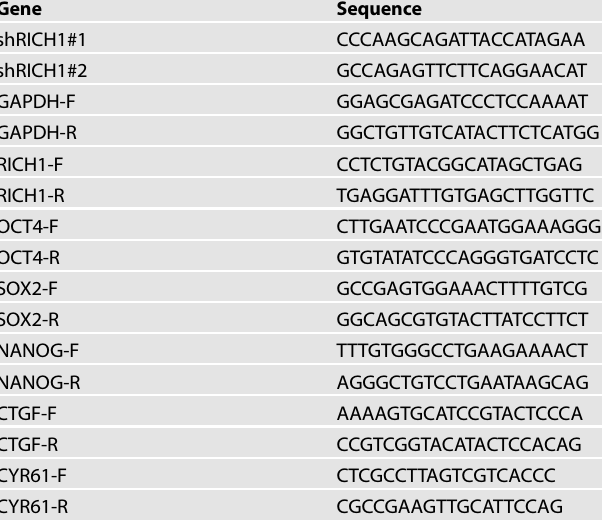
Table 2. The sequences of shRNA and primers for real-time PCR